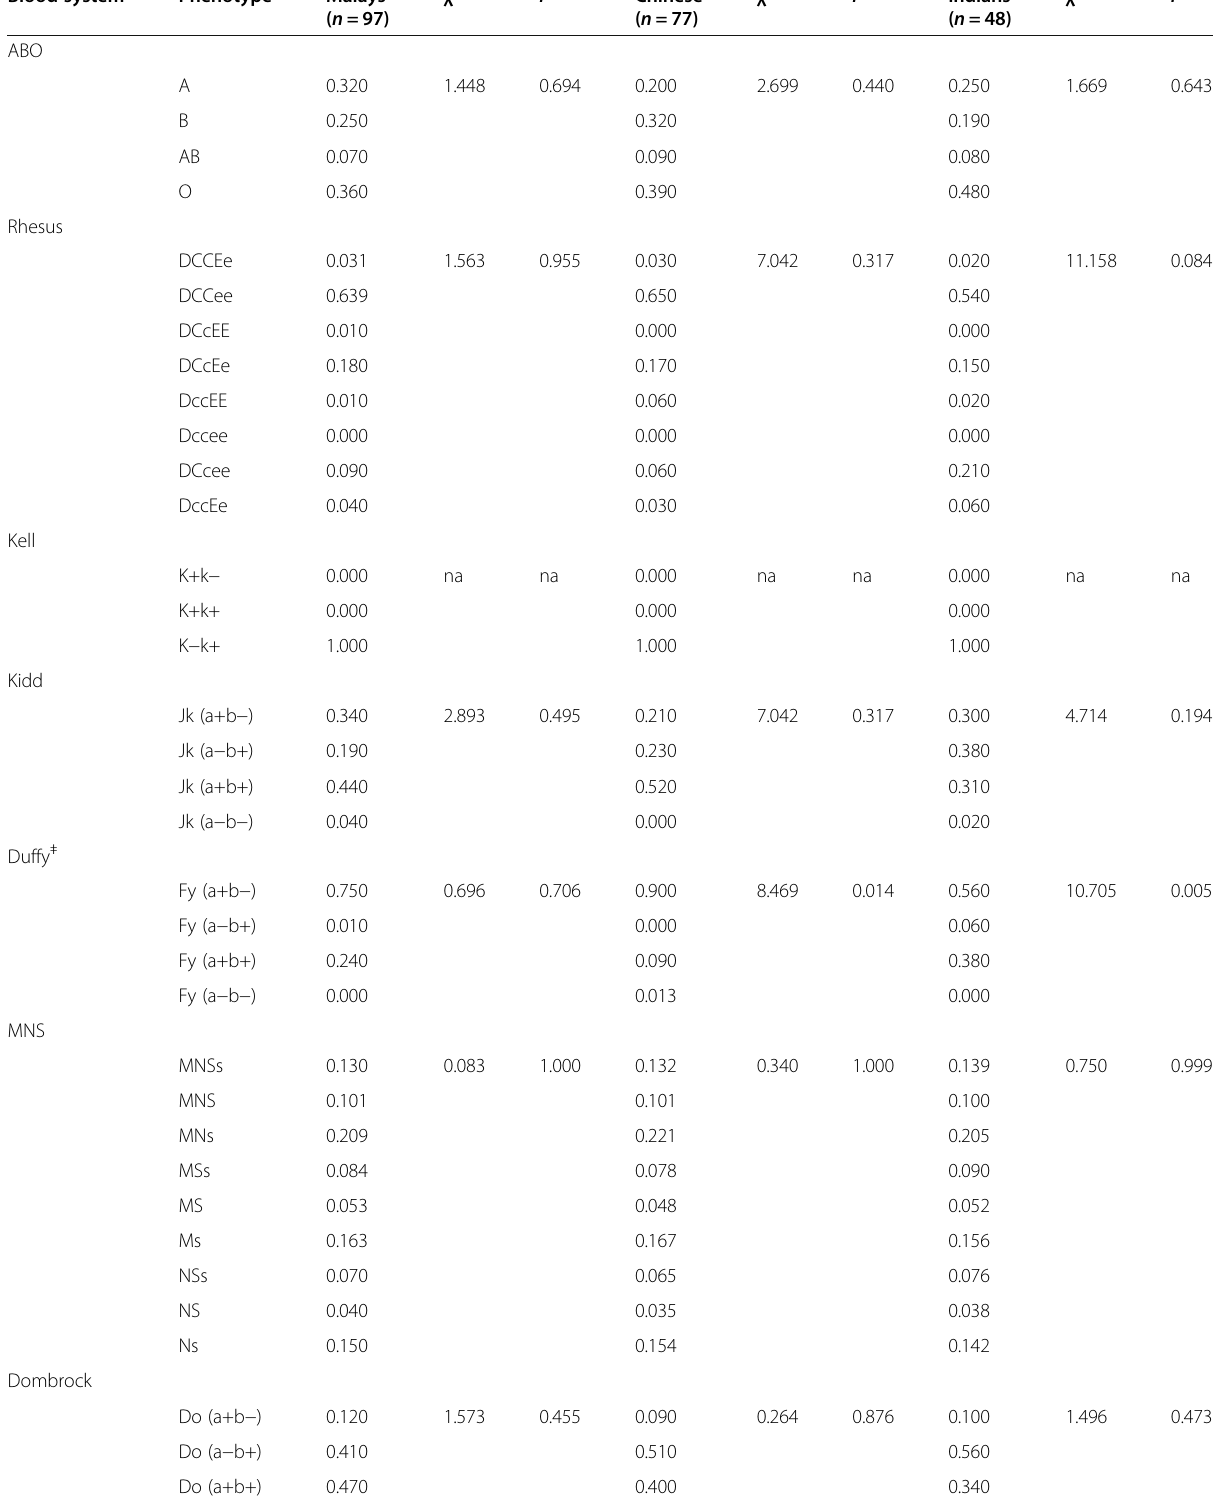
Table 1 Phenotype frequencies and HWE analysis of blood group systems in Malays, Chinese, and Indians Blood